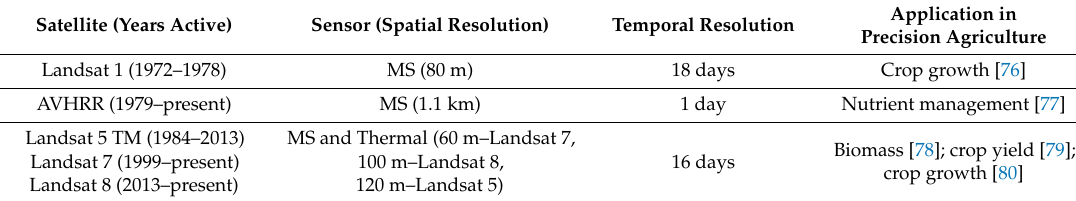
Table 1. Spatiotemporal resolutions of the satellite sensors used for precision agricultural (PA) applications. Satellites that provide high spatial ( < 30 m) and temporal resolutions (e.g., daily) are more suitable for